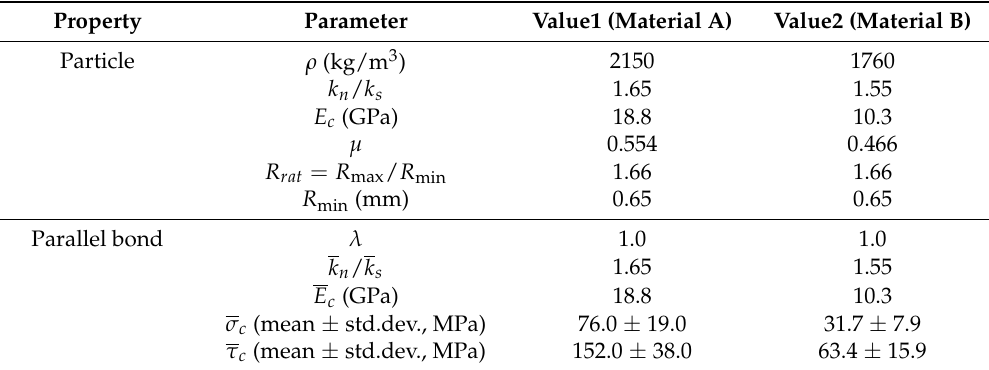
Table 1. Microparameter values of intact rock materials (material A and material B).